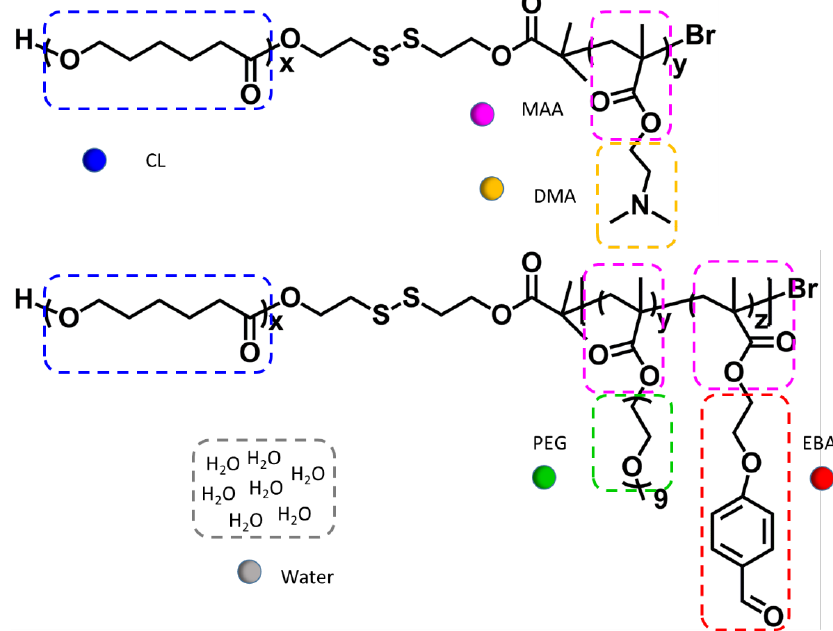
Figure 8. Molecular structures and coarse-grained models of the polymers PCL-SS-PDMAEMA and PCL-SS-P(PEGMA- co